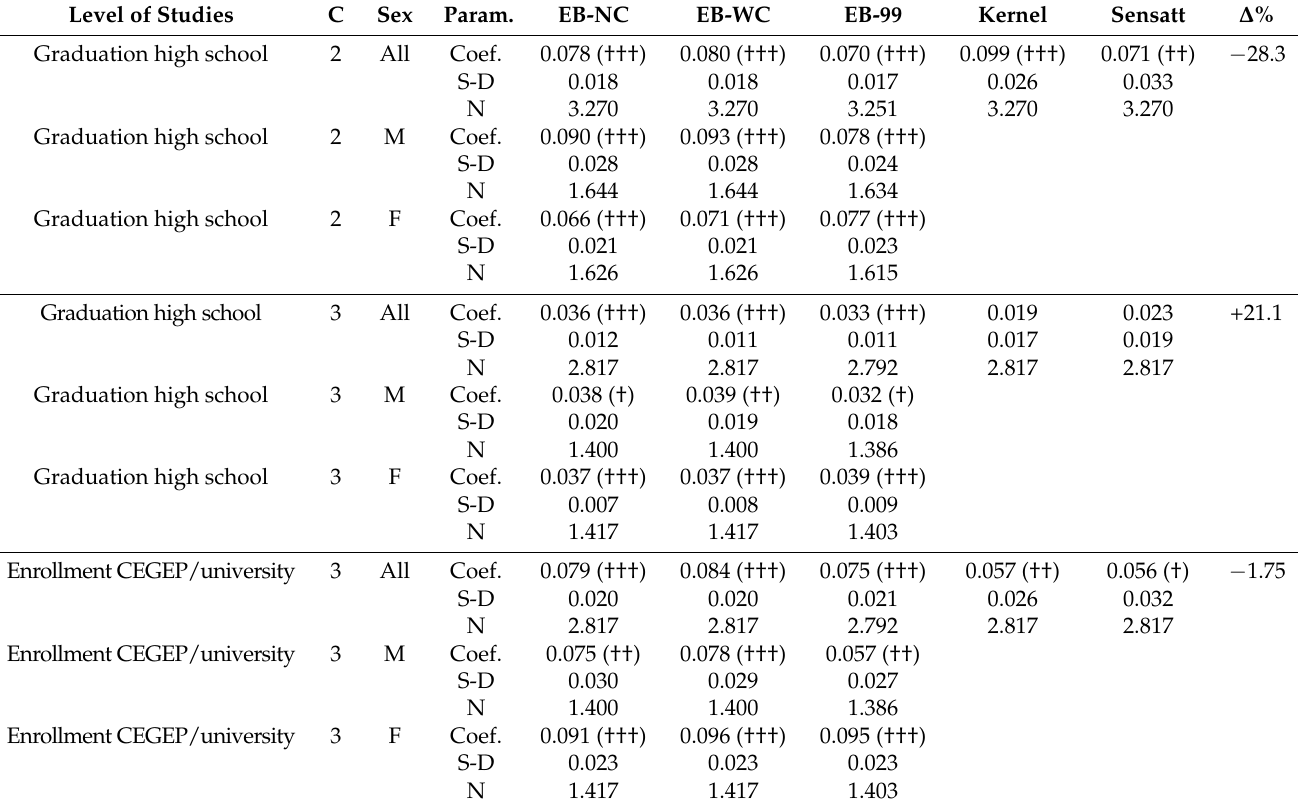
Table 4. Estimated effects of independent high school on high school graduation by sex and estimation methods, cohort A cycles 2 and 3,